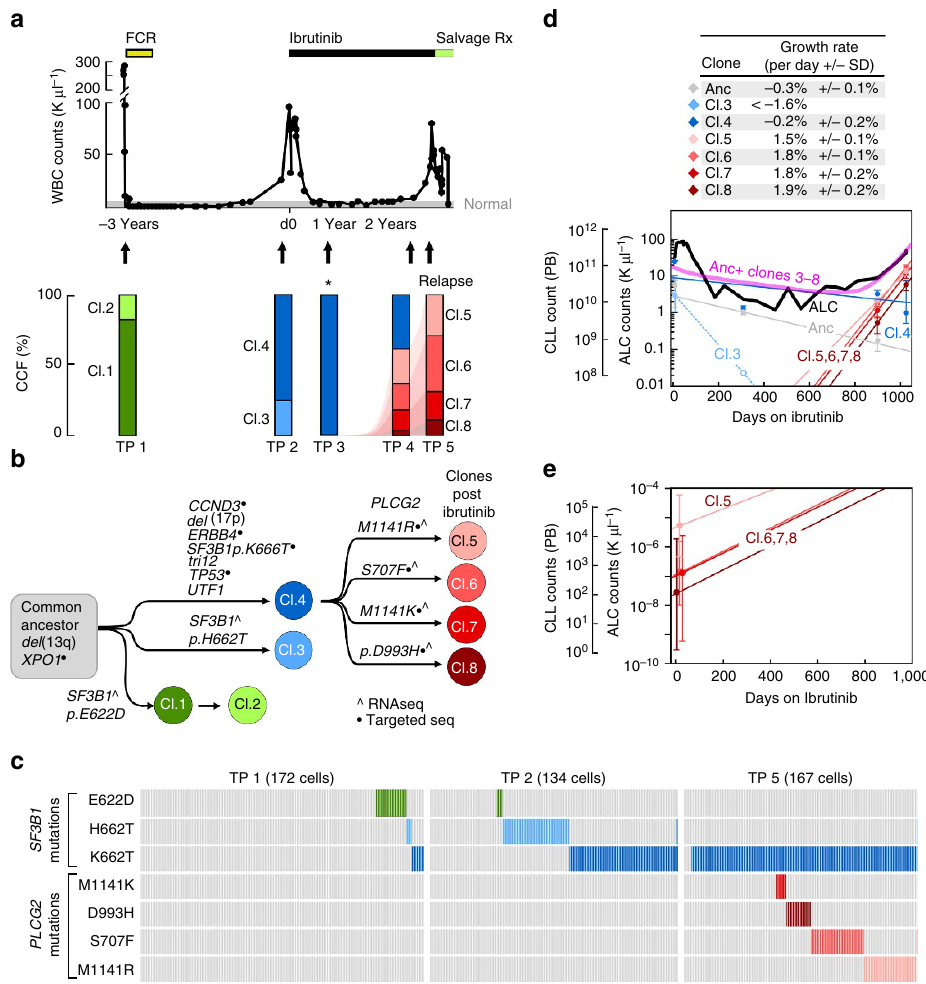
Figure 1 | Evidence of clonal evolution with late disease progression following ibrutinib. ( a ) White blood cell counts and treatment course of Patient 1. Peripheral blood specimens were sampled at five time points (indicated by arrows), and CLL cells underwent whole-exome sequencing. Following somatic mutation calling, CCF of somatic variants was inferred by ABSOLUTE analysis of deep-sequencing data of the detected mutations (see Supplementary Figs 1 and 2). Asterisk indicates that this sample had less purity, and hence clone sizes are estimates. ( b ) A phylogenetic tree was inferred based on PHYLOGIC, a novel algorithmic extension of ABSOLUTE. Driver mutations associated with each clone are indicated (a complete listing of somatic mutations and allelic fractions found for each clone in Supplementary Table 2 and Supplementary Figs 1 and 2). ( c ) Multiplexed detection of somatic mutations in 134–172 single cells of Patient 1 at TP1, TP2 (pre-ibrutinib) and TP5 (ibrutinib relapse). Between all three time points, shifting cell subpopulations with SF3B1 mutation are observed. At TP5, SF3B1-K666T is detected in all cells, while the various PLCG2 mutations are detected in distinct subpopulations. Single-cell expression levels of wild-type (WT) and mutated (MUT) PLCG2 are shown in Supplementary Fig. 3B. ( d ) The clonal kinetics during ibrutinib treatment. Filled circles—measurement of the number of cells comprising each subclone at each time point based on the subclone CCF and the corresponding ALCs. Measurements are shown with 95% confidence interval (CI) obtained from posterior distributions of CCFs. Empty circles—upper bound estimates (1% of total CLL cells) for subclones that were below the detection threshold of targeted deep sequencing. Solid lines denote predicted kinetics for clones detected on at least two measurements. Dashed lines represent kinetics with minimal absolute growth rates for clones detected in only one measurement. ( e ) Extrapolation of clone size with 95% CI at the time of treatment initiation for the PLCG2 -MUT